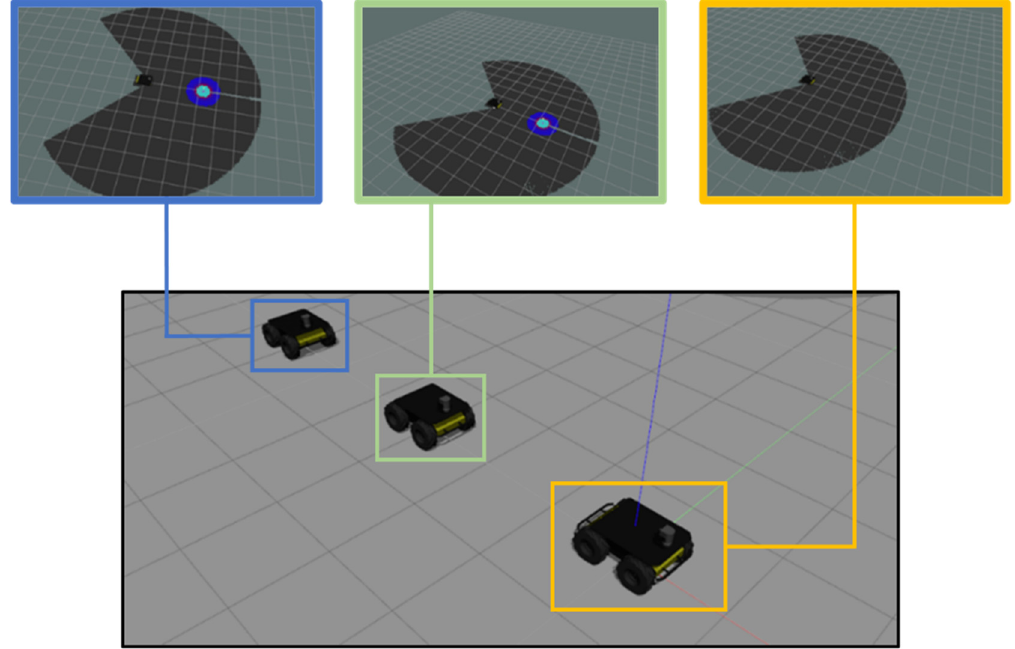
Figure 5. Convoy of Clearpath Husky robots in the Gazebo robotics simulator with each robot’s sensor visualization in ROS tools.